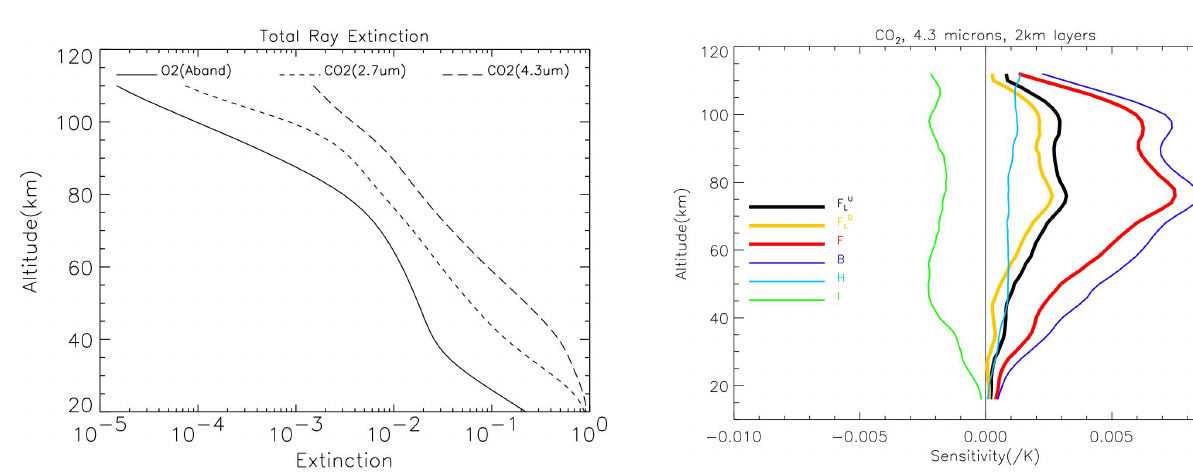
Fig. 2. Broadband limb-path extinction profiles for the 760nm O 2 A-band and 2.7 and 4.3µm CO 2 . Extinction is defined as ( 1 − τ S ) .